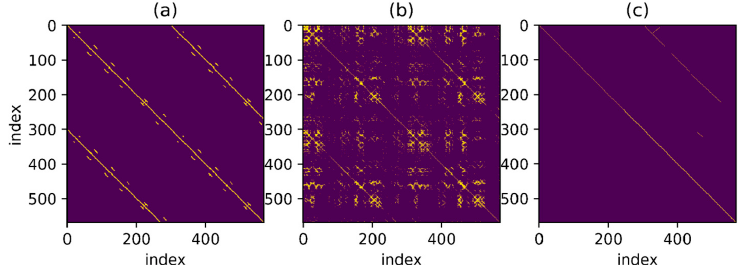
Figure 15. RANSAC-based matching result of Path A. ( a ) Matching relationship generated from the reference trajectory. ( b ) Results when MFD is higher than the threshold. ( c ) Selected matching points based RANSAC.